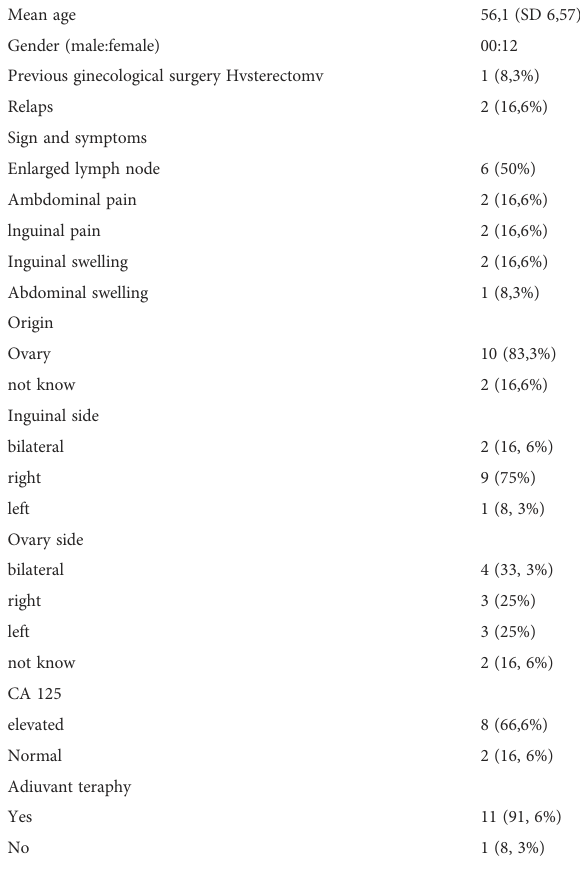
TABLE 3 Baseline characteristics, presenting symptoms and type of treatment